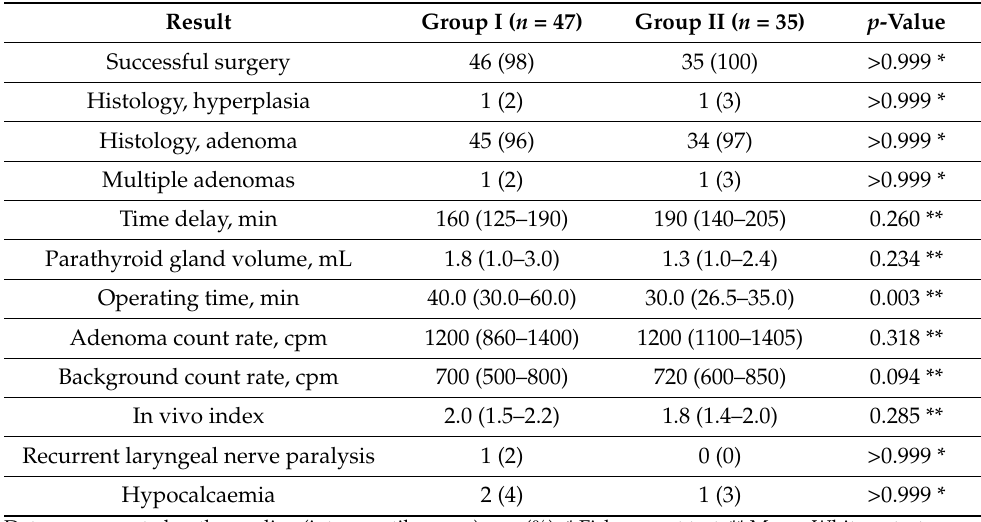
Table 2. Comparison of results between groups.